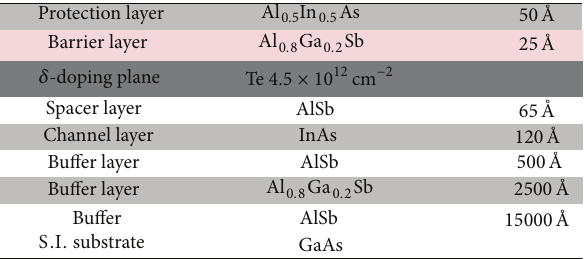
Figure 1: AlSb/InAs heterostructure.